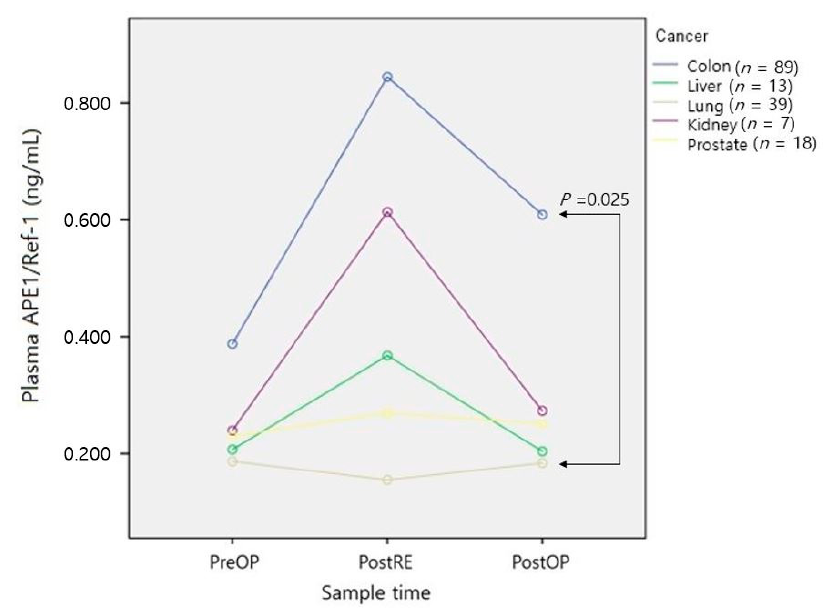
Figure 6. Changes in plasma APE1/Ref-1 level according to cancer type. PreOP, preoperative sample; PostRE, postresection sample; PostOP, postoperative sample.